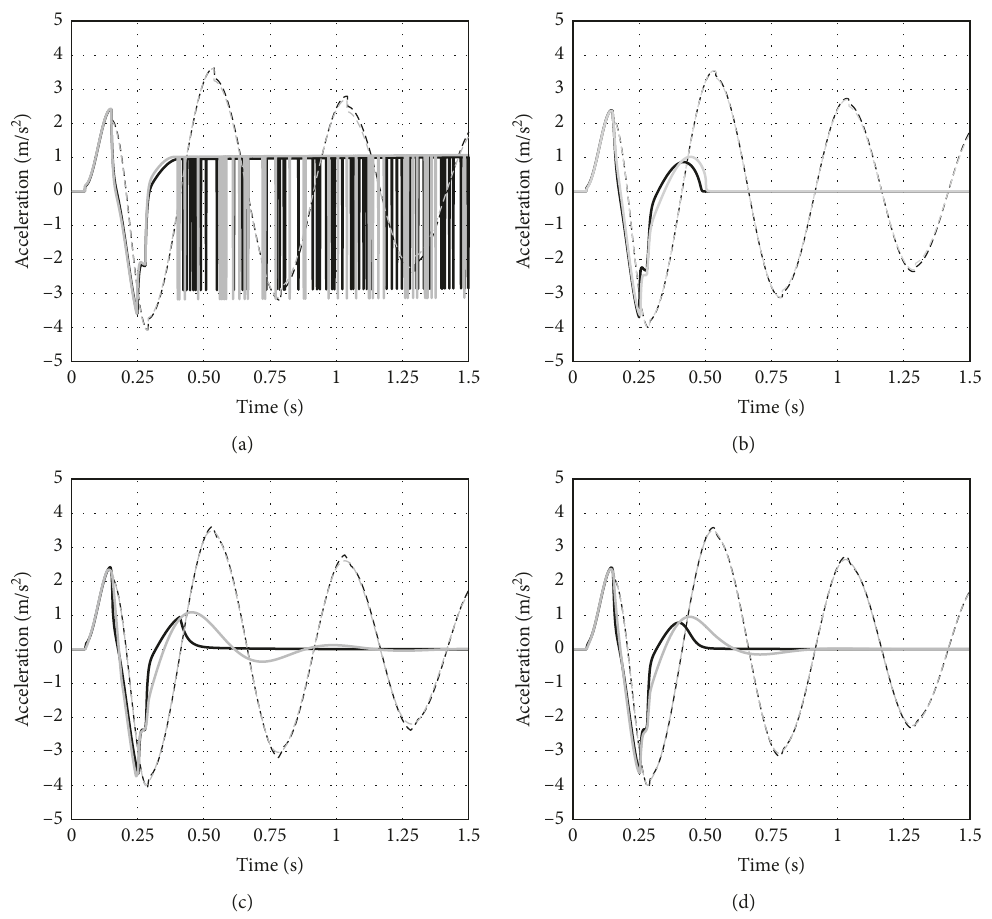
Figure 18: Time response of the controlled (solid line) and passive (dotted line) sprung mass acceleration for the (a) Bingham model, (b) Herschel–Bulkley model, (c) biviscous model, and (d) regularised Bingham model, after LMH fitting (black) and MH fitting